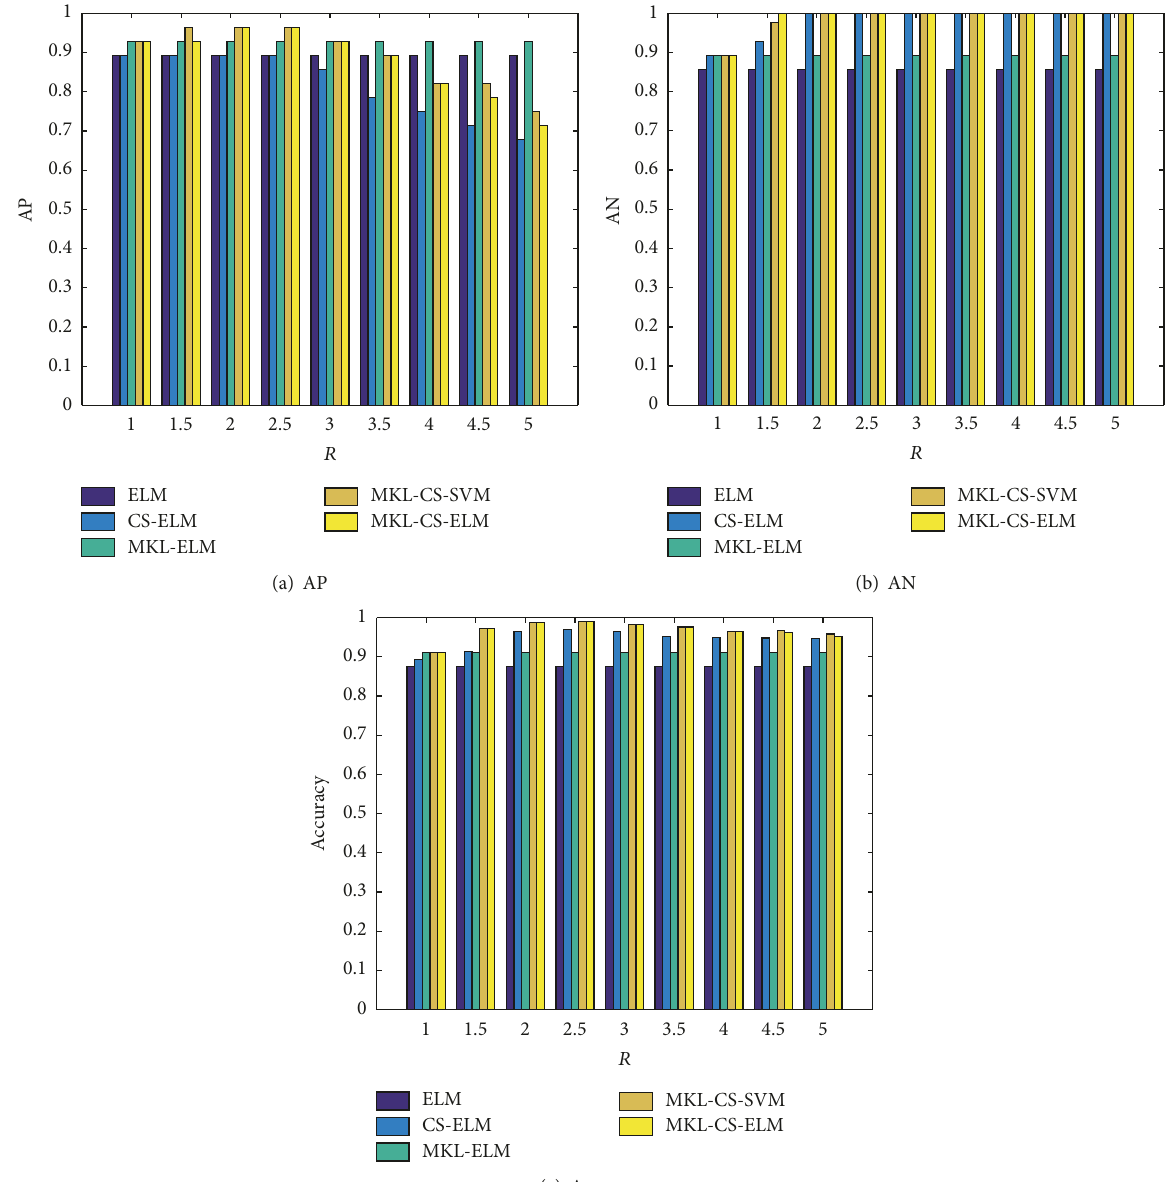
Figure 6: The recognition results of five classification models in